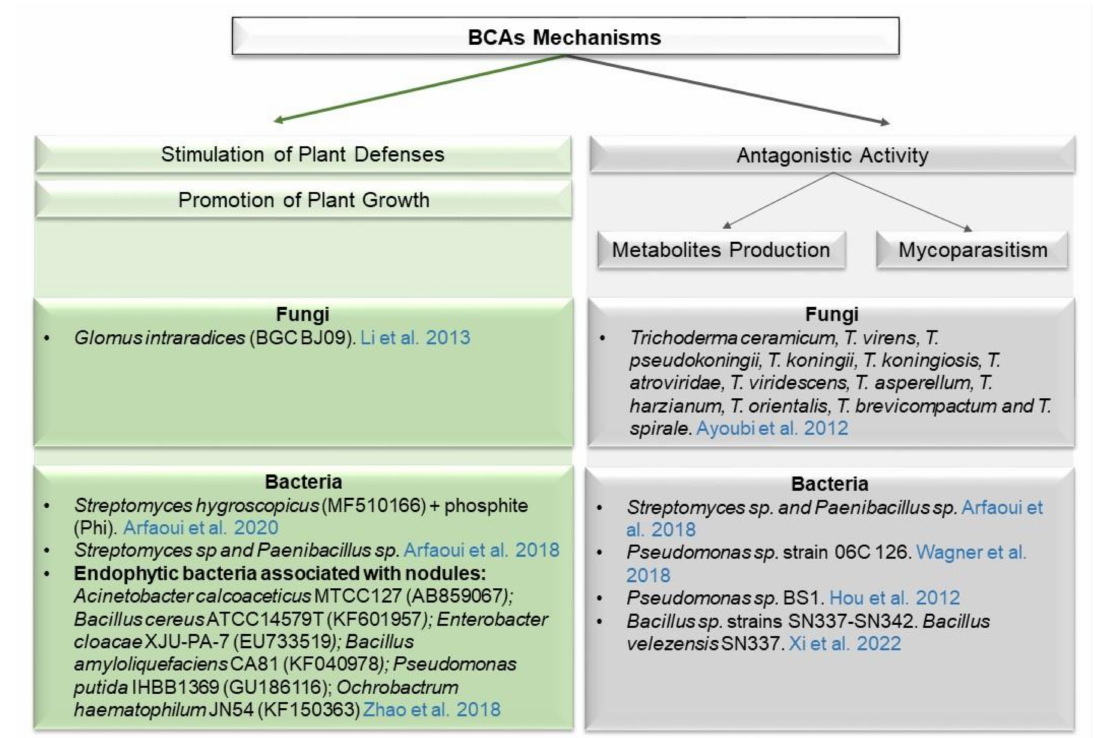
Figure 2. Biocontrol agents for the management of the Phytophthora root rot and the associated mechanisms. In green are BCAs (fungi and bacteria) associated to the promotion of plant growth and stimulation of plant defense. In grey are BCAs (fungi and bacteria) with antagonistic